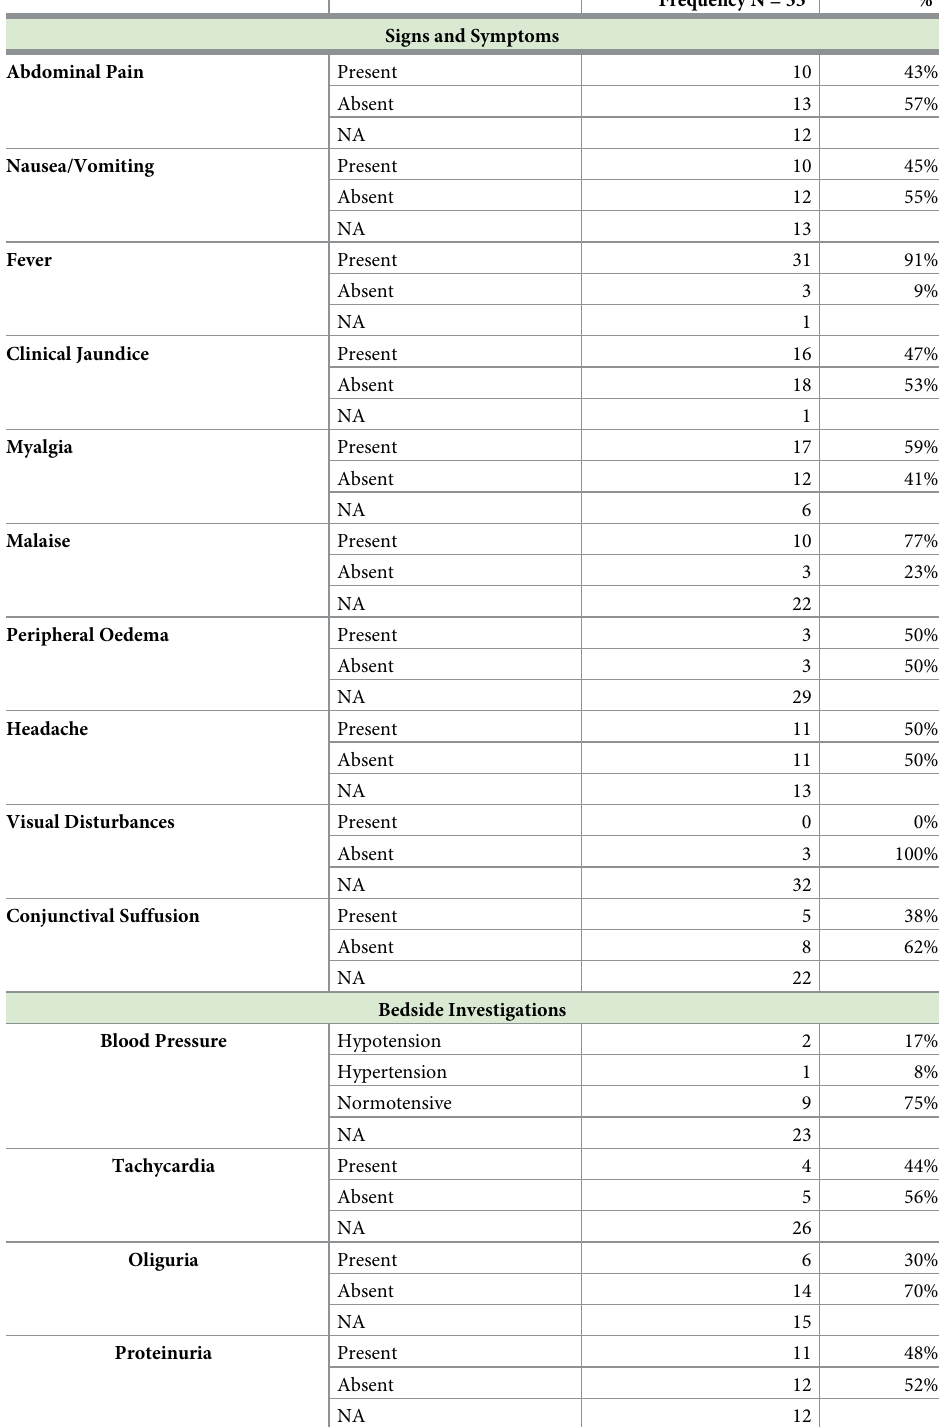
Table 5. Clinical characteristics of leptospirosis in